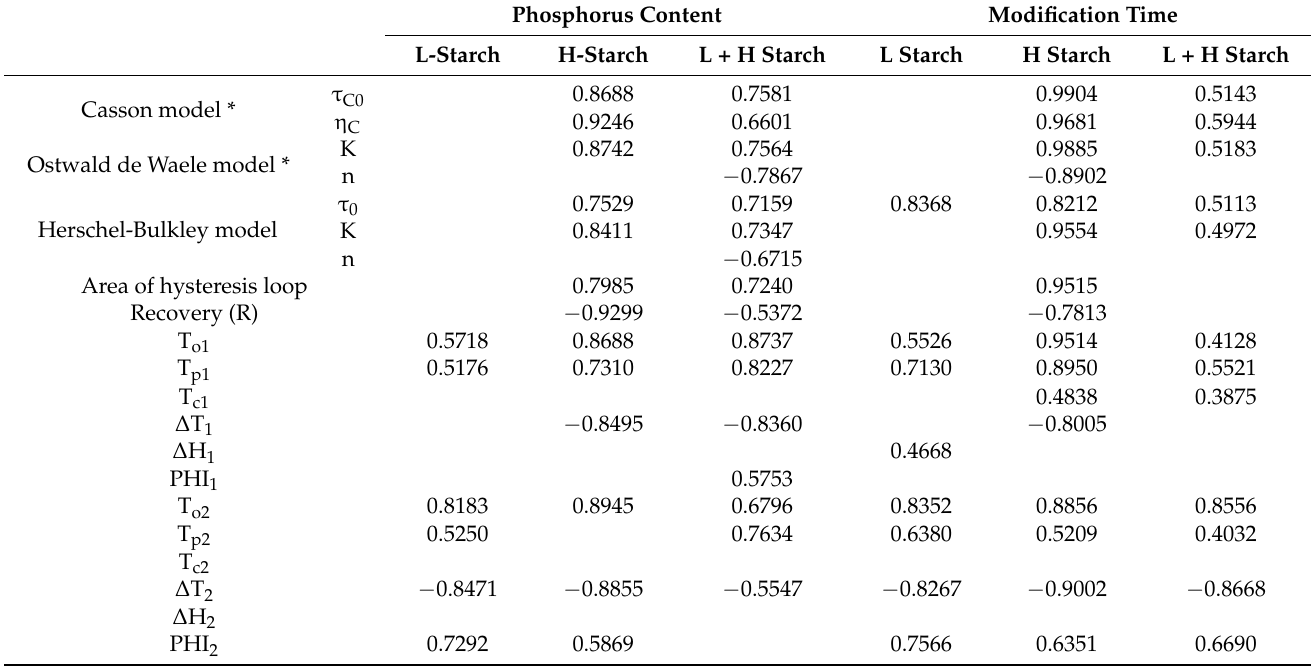
Table 7. Statistically significant Pearson’s correlation coefficients between physicochemical parameters and phosphorus content or modification